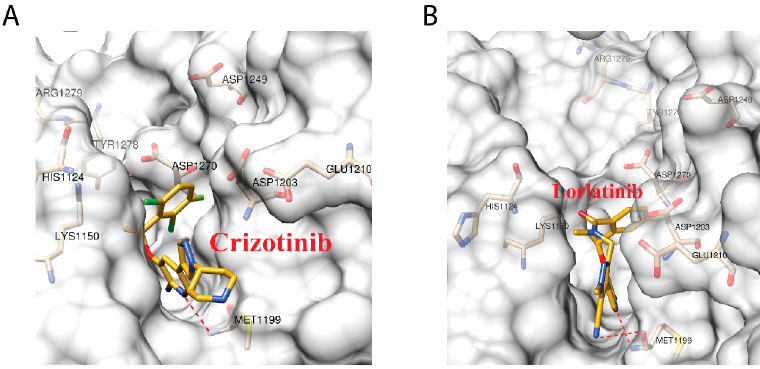
Figure 2. ALK–crizotinib (panel A , PDB ID: 5AAB) and ALK–lorlatinib (panel B , PDB ID: 5AA8) complexes structures. The ligands and key amino acid residues of ALK are presented as stick models. The dashed red lines represent the hydrogen bonds predicted by Ligplot+.